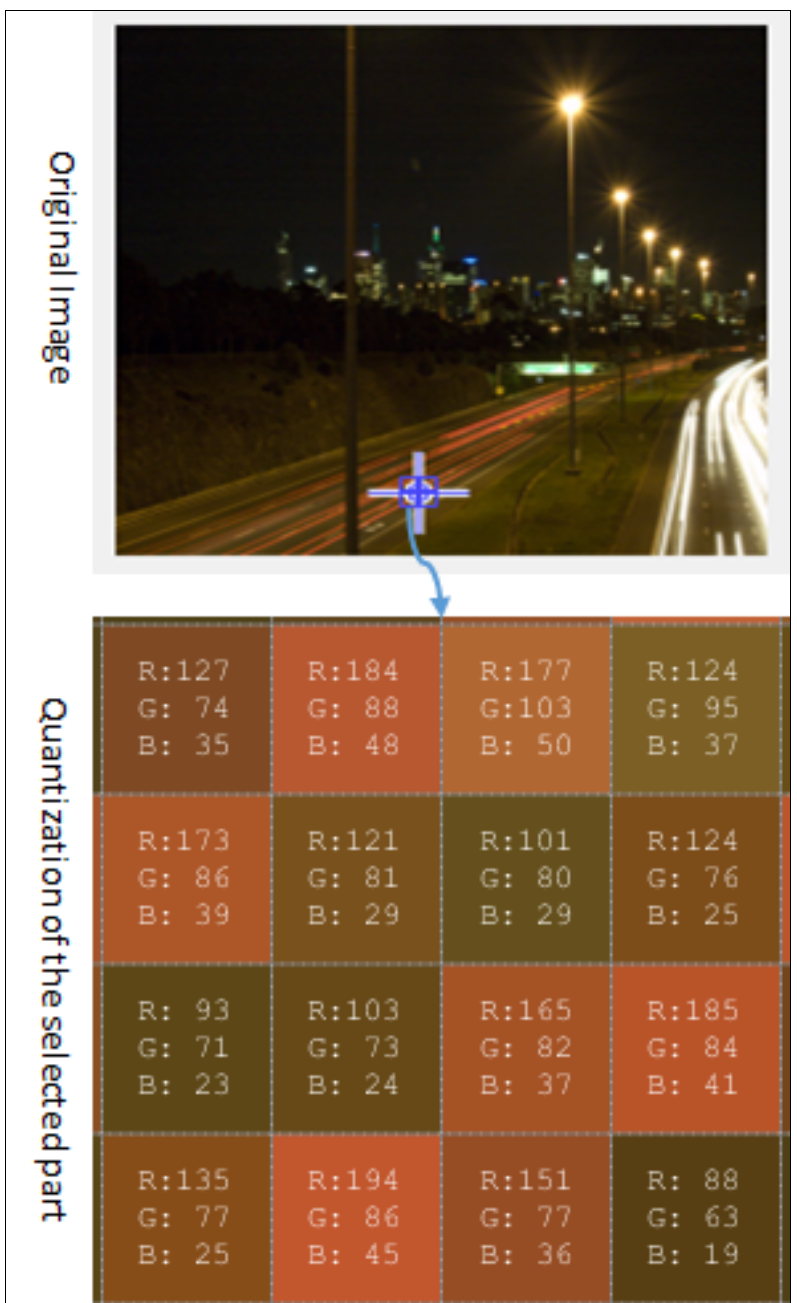
Figure 4. An 8-bit red, green, and blue (RGB) image. For an uncompressed image (X), the memory that is required to store the image is calculated using Equation (1), where the dimensions of the image are A × B , the bit depth is N, and required storage is S